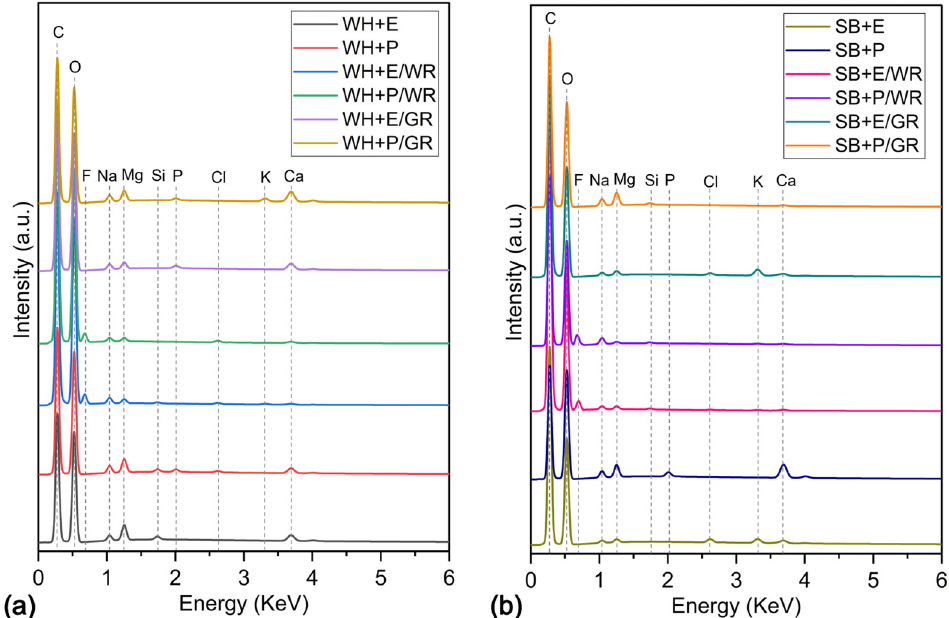
Figure 4. ( a ) EDX spectrum of standard (WH + E, WH + P), water-repellent-treated (WH + E/WR, WH + P/WR) and gamma-irradiated (WH + E/GR, WH + P/GR) water hyacinth composites, and ( b ) EDX spectrum of standard (SB + E, SB + P), alkali-treated (SB + E/WR, SB + P/WR) and gamma- irradiated (SB + E/GR, SB + P/GR) sugarcane bagasse composites.